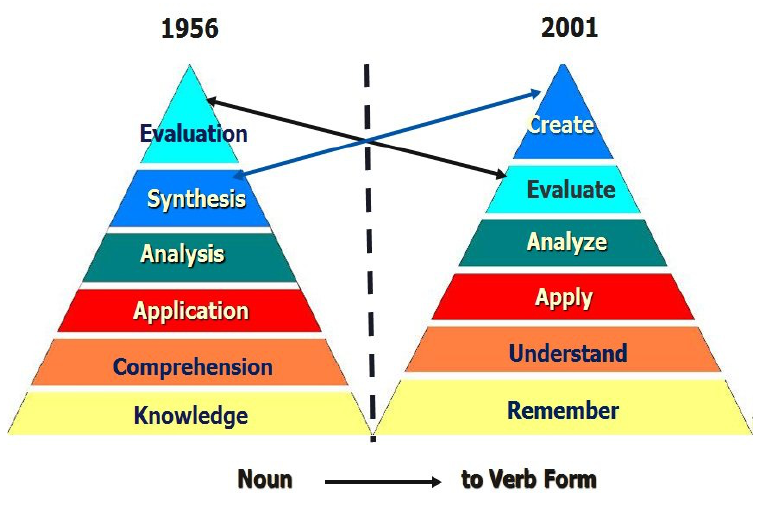
Fig. 4. Bloom’s vs Anderson’s/Krathwohl’s Taxonomy https://dreamlikechild.weebly.com/blooms-vs-andersonkrathwohl-taxonomy-revised.html